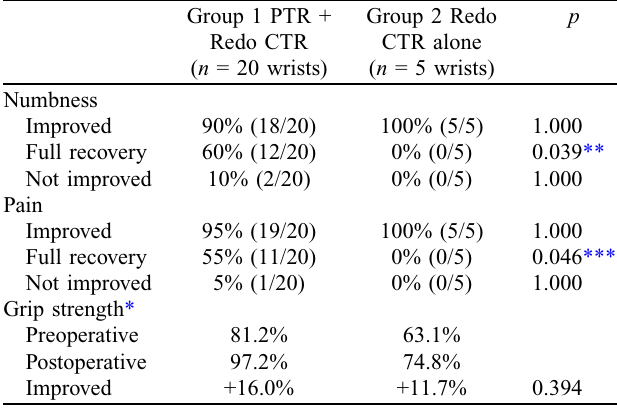
* Grip strength was reported in percentage by comparison with contralateral normal wrist. (Excluded three bilateral diseases in group 1; 6 wrists). **,*** Statistically significant between group 1 and group 2 ( p <